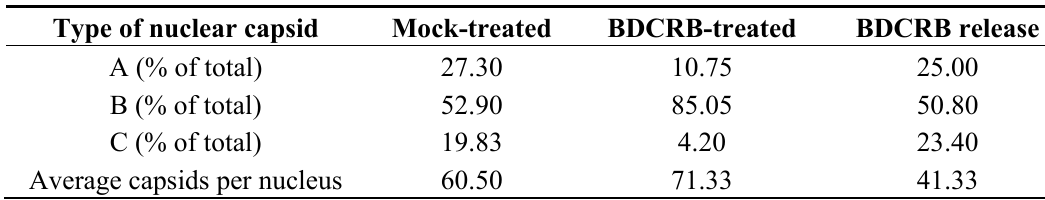
Table 1. Distribution of nuclear capsid types in mock-treated, BDCRB-treated and BDCRB released infected cells. Average number of particles from 6–9 different micrographs spanning at least 3 different infected cell for each sample were identified based on their established characteristics